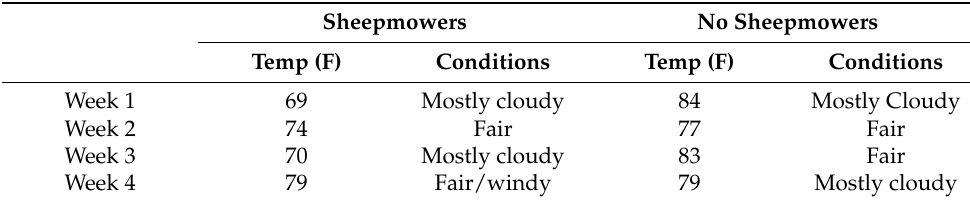
Figure 2. Site accessibility. Table 1. Environmental Conditions on Data Collection